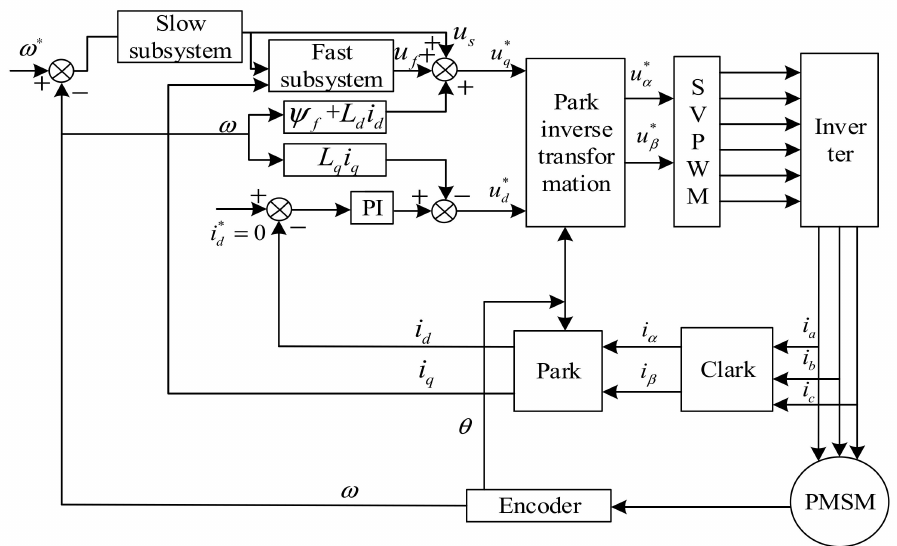
Figure 3. Schematic diagram of second-order sliding mode control of PMSM based on singular perturbation theory.